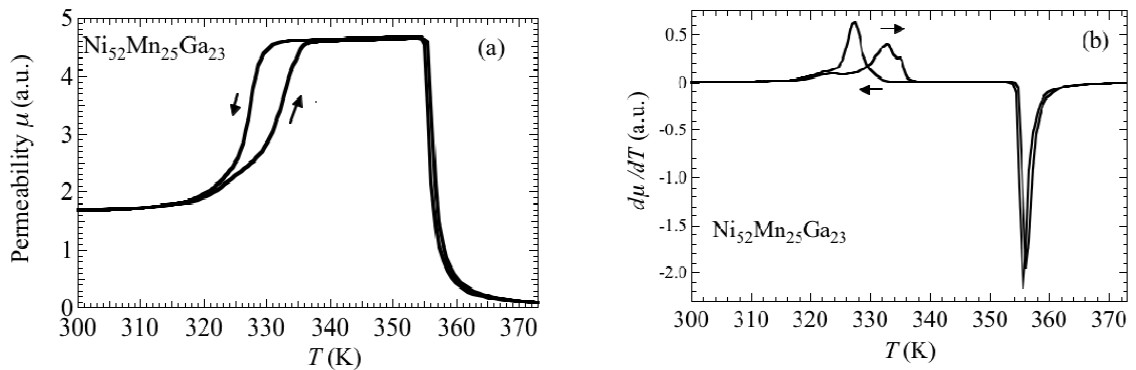
Figure 2. The temperature dependence of the permeability of Ni